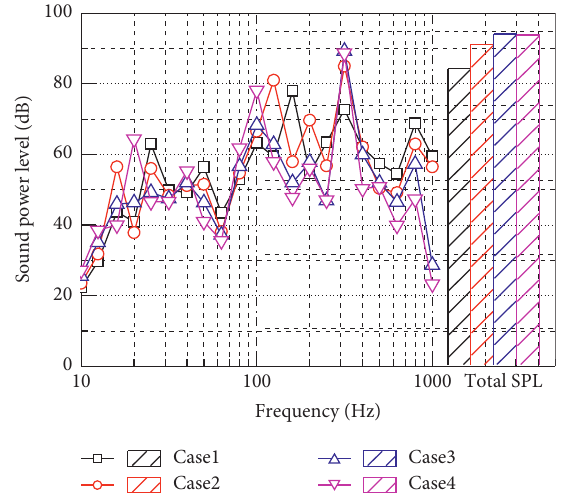
Figure 12: Plots of sound power level frequency for various numbers of shear studs.